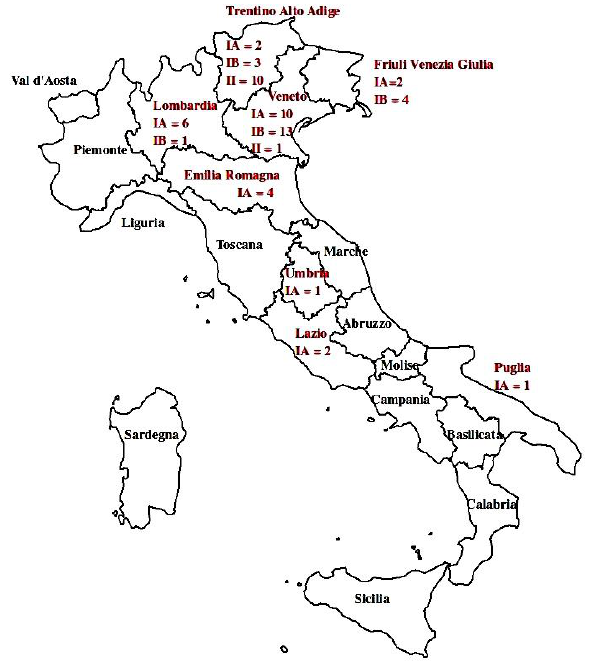
Figure 2. Geographical origin of the new sequenced strains: the numbers shown represent the strains isolated in each Italian region. The names of the regions where strains were isolated are in red,